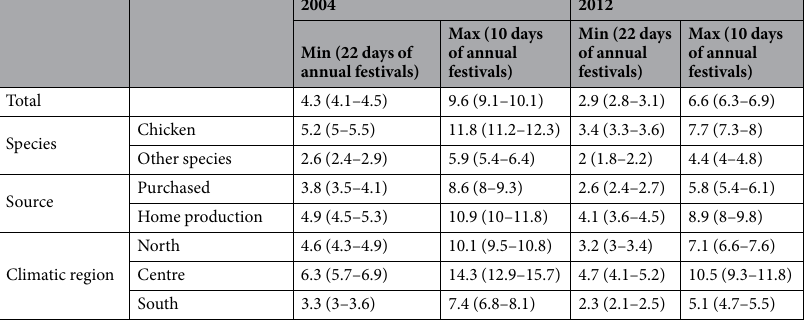
parameters were fixed. We assumed that the duration of this at-risk period (period during which the infectious contact rate β t = β C ) was 14 days (7 days prior to and after the Lunar New Year date, respectively). The estimated ratios β C / β 0 were highly variable and strongly influenced by the assumed duration of the infec- tious period (4 days or 13 days) (Table 2). However, for every set of parameters, the estimated infectious contact rate was always higher during the Lunar New Year period than during the remainder of the year ( β C / β 0 > 1) in all climatic regions. The 95% credible intervals of posterior β C / β 0 of the three regions overlapped. Distributions of posterior ratios β C / β 0 in the Centre and South regions were very close to each other, but the one in the North differed from those in the Centre and South, with a slightly lower median (Table 2). Posterior values of β 0 and β C are displayed in Supplementary Table S1. Results of posterior predictive checks are displayed in Table 3 and partly illustrated in Fig. 5, using only one set of fixed parameters. Results obtained with other parameter values are displayed in Supplementary Fig. S2. 100% of the observed cumulative distribution of AIO waiting times was contained within the minimum and maximum values simulated using the estimated β 0 and β C (Fig. 5) except for one set of parameters in the South (infectious period of 13 days and delay before repopulating the farm of 45 days) (Table 3). Pearson correlation coefficients between observed and simulated weekly AIOs counts were variable, but consistently higher than 0 in the 3 regions of the country, further suggesting that the model reproduced seasonal variations in AIO occurrence in these 3